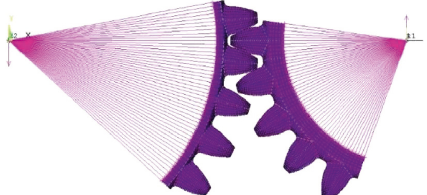
Figure 3: Finite element model of modified gear pair.